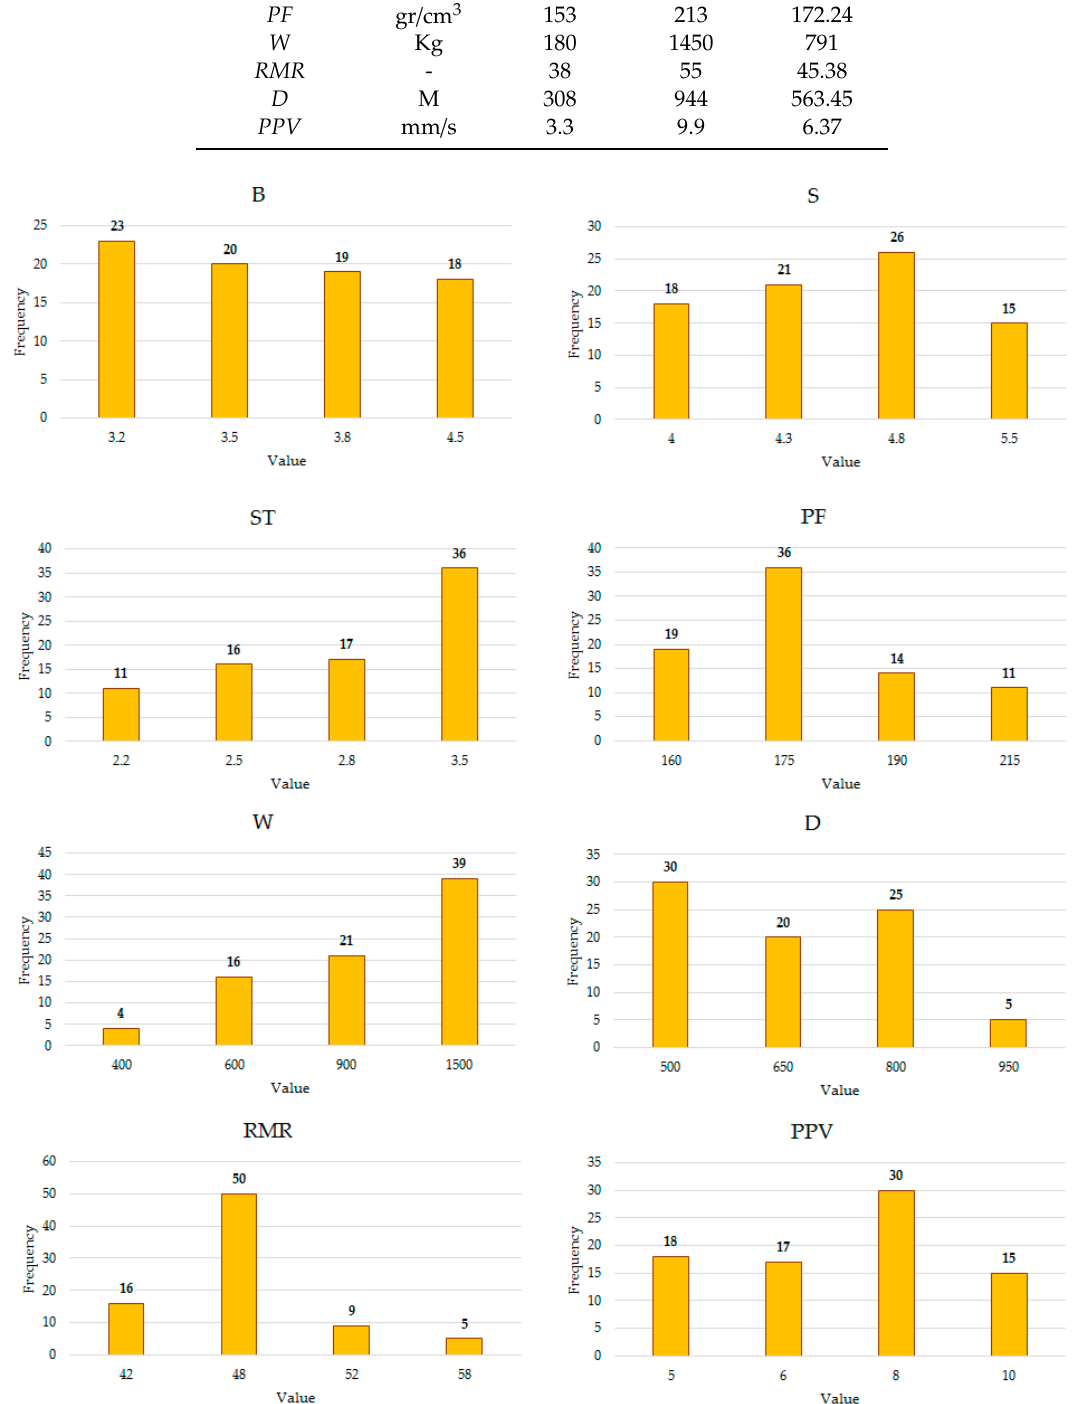
Figure 4. Histograms of the input and output parameters.